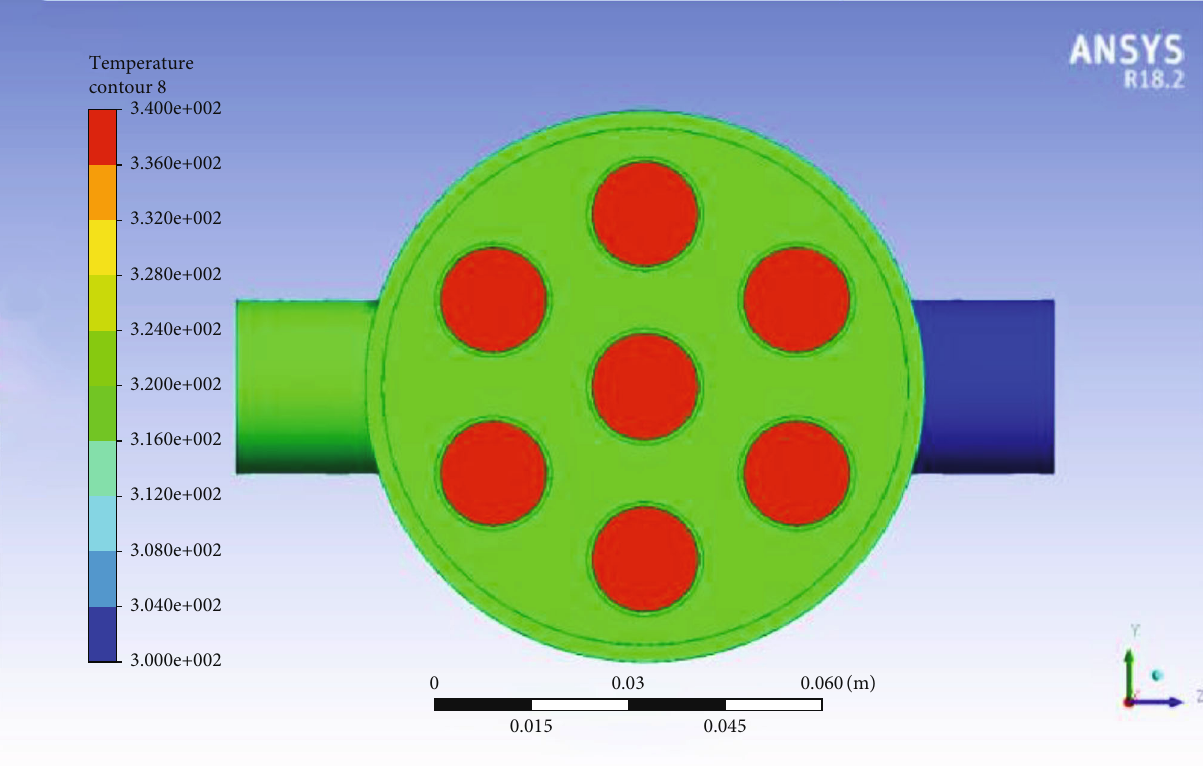
Figure 7: Temperature contour at inlet of the hot fl